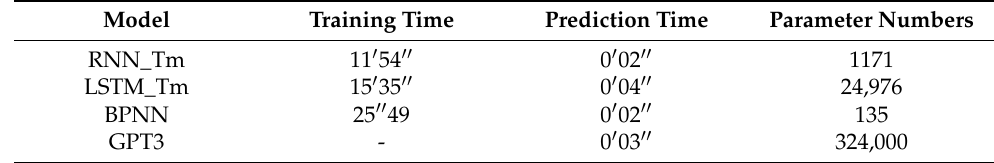
Table 2. Training and prediction times and the number of parameters of the different models.